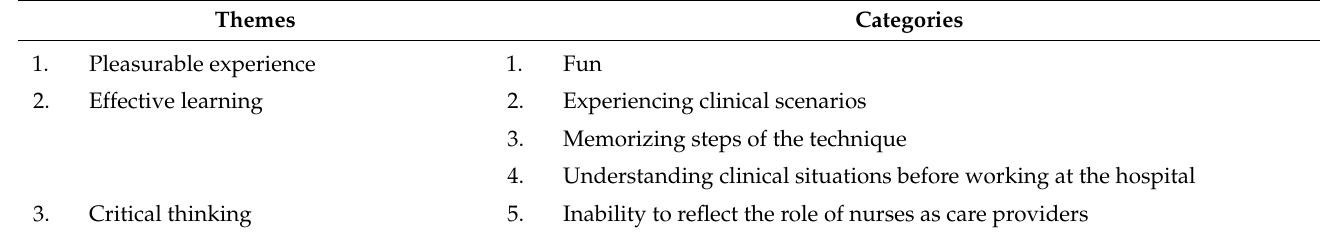
Table 2. Learning experience summary